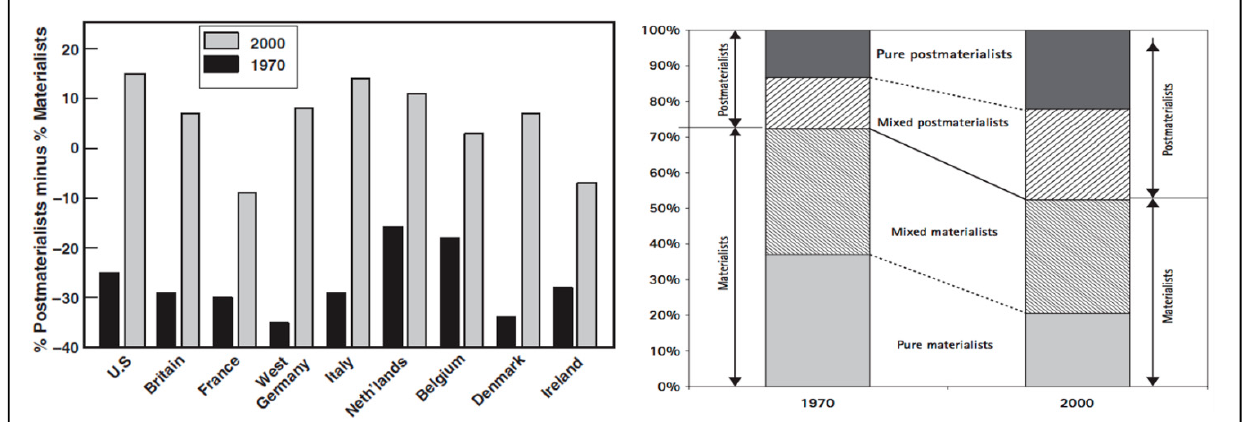
Figure 10. A shift toward post-materialist values among the publics of nine Western societies, 1970 and 2000. Source: [42].